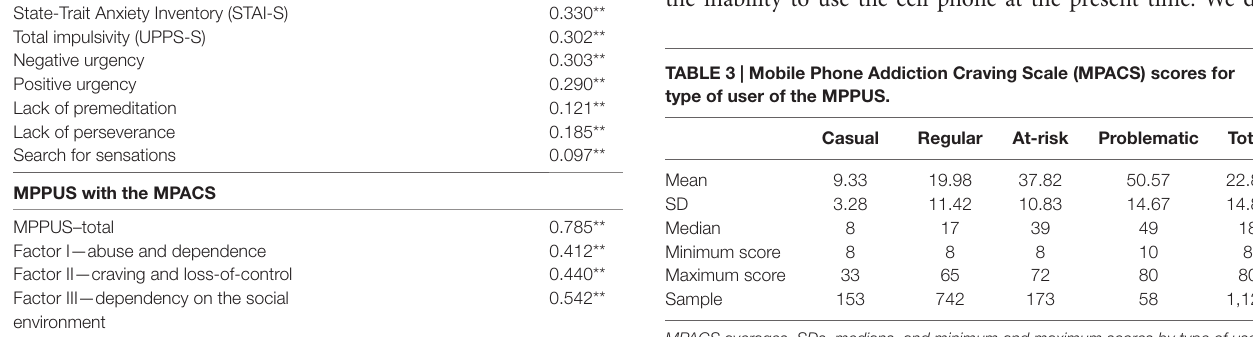
Table 2 | correlations of the Mobile Phone addiction craving scale (MPacs) with state anxiety, impulsivity, and the MPPUs. state anxiety and impulsivity with the